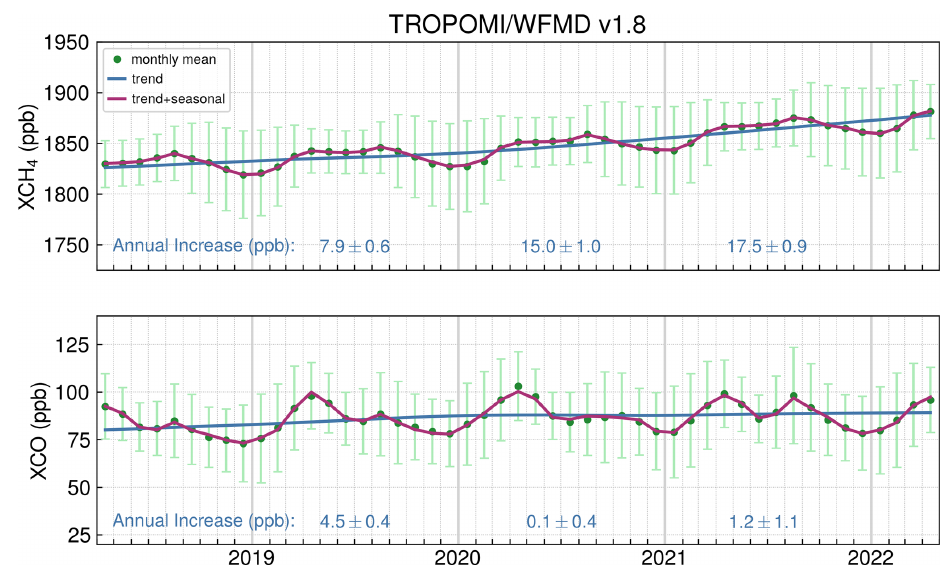
Figure 21. Time series of globally averaged monthly gridded TROPOMI/WFMD v1.8 data. The underlying area-weighted monthly means are shown as green dots with the associated standard deviation as bars in lighter green. The season–trend decomposition used to derive the annual increase is done using locally estimated scatterplot smoothing (LOESS). The trend component is shown in blue, and the sum of the trend and seasonal component is shown in